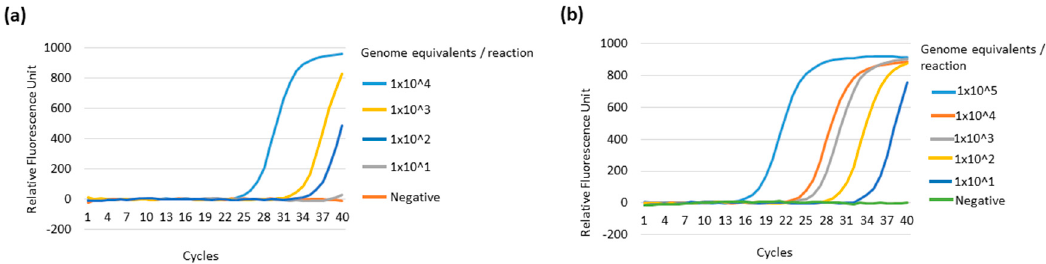
Figure 4. The sensitivity of real-time qPCR using genomic DNA from in vitro cultured organisms. ( a ) shows the amplification curve of R. monacensis by qPCR based on the Rickettsia OmpA gene. ( b ) shows the Plasmodium 18S rRNA gene amplification curve using the P. falciparum . The qPCR showed detection up to 100 ( a ) and 10 ( b ) genome equivalents for in vitro cultured R. monacensis and P. falciparum, respectively.